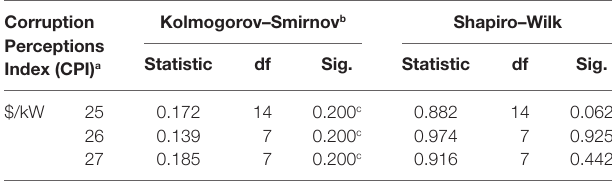
taBLe 2 | Test of